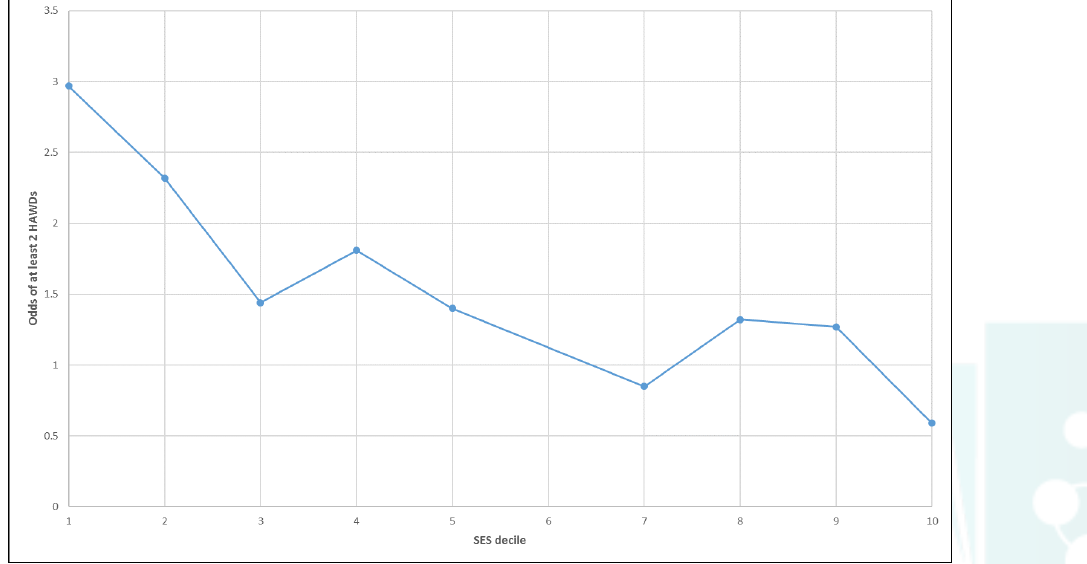
Figure 1: Odds of at least two hospitalizations associated with depression over the combined period according to socio-economic status